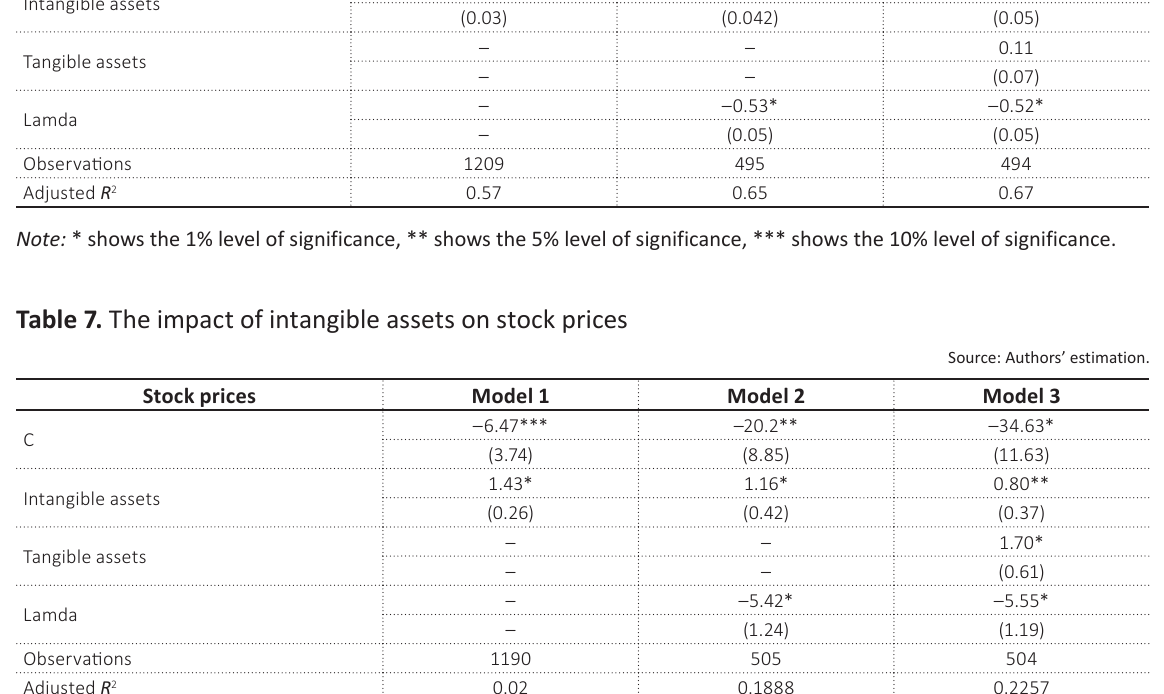
Table 6. The impact of intangible assets on EBIT